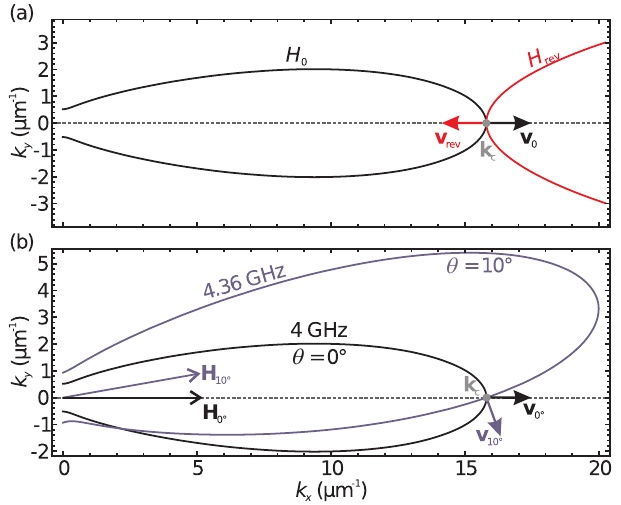
Figure 5. ( a ) Illustration of the reversal of a spin-wave packet in the reciprocal space. The initial isofrequency curve, belonging to f 0 = 4 GHz and an external magnetic field of µ 0 H 0 = 16m T is marked in black. After an increase of the magnetic field to µ 0 H rev = 350 m T the central frequency shifts to f rev = 18.51 GHz , according to the wave-vector conservation. The resulting isofrequency curve is depicted in red. Initial and resulting group velocity are denoted as black and red arrows, respectively. ( b ) Isofrequency curves for the case of a magnetic- field tilt of 10 ◦ . The initial isofrequency curve is depicted in black. Marked in blue is the isofrequency curve for the tilted external field. Again, due to wave-vector conservation the central frequency adapts to f c = 4.16 GHz . The initial and resulting group velocities are denoted as black and blue arrows,